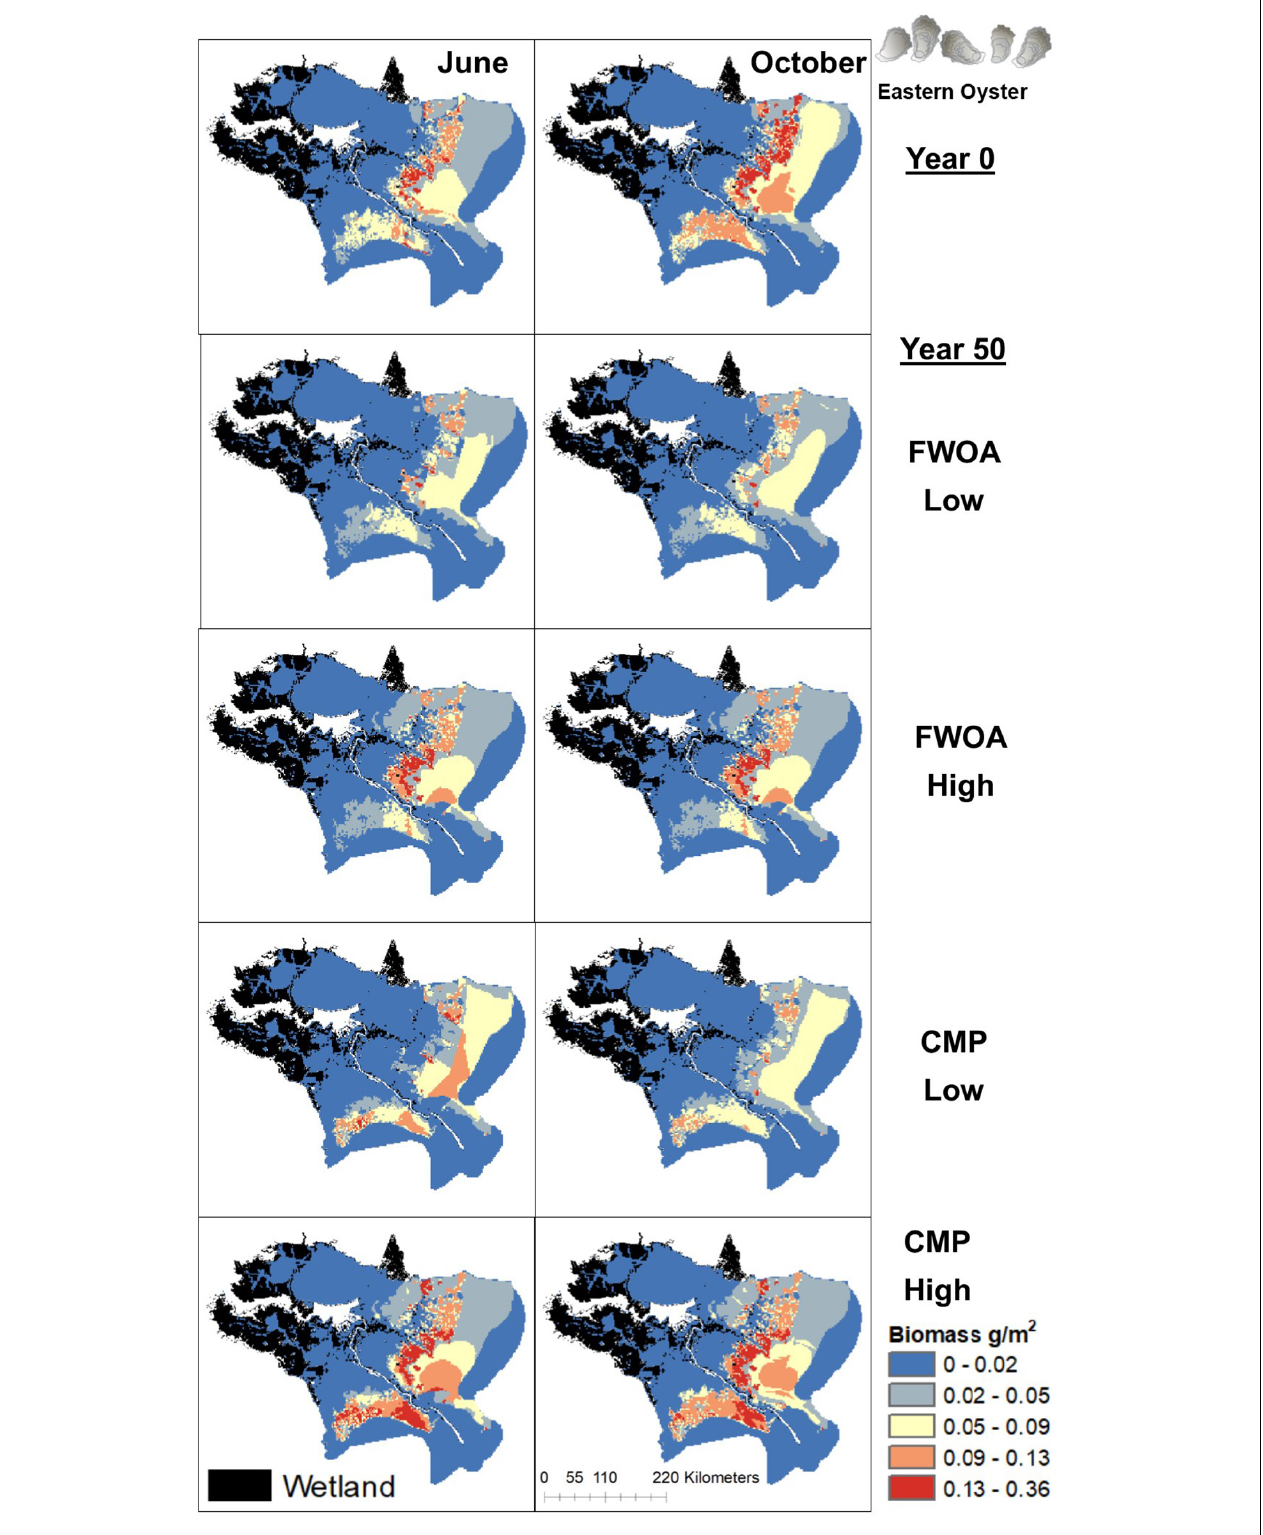
FIGURE 11 | Spatial distribution of adult Eastern Oyster in different simulations. Output is shown from June and October in Year 0 and Year 50, under “Low” and “High” relative sea level rise (see Supplementary Table S6 for scenarios), and with Coastal Master Plan (CMP) implementation and without (FWOA).